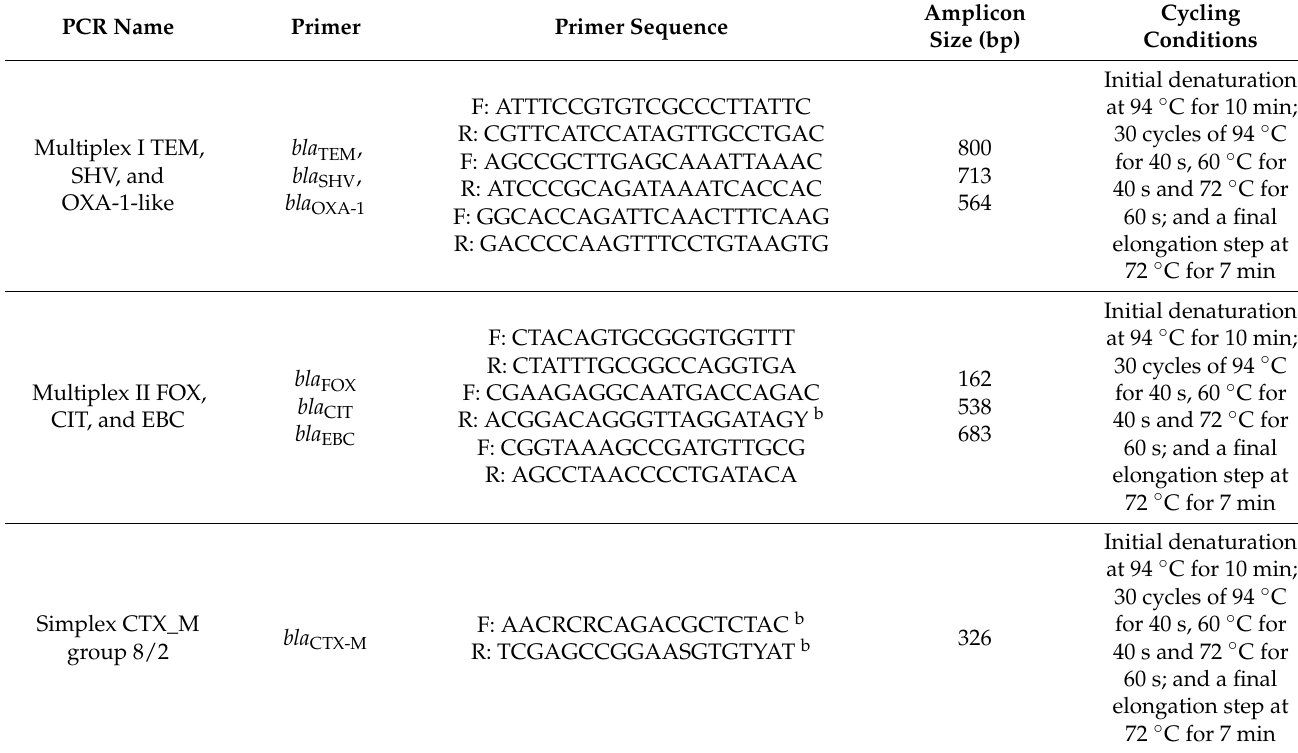
Table 3. Group-specific primers and cycling conditions used for the detection of Extended Spectrum Beta-Lactamases (ESBL) antibiotic resistance genes